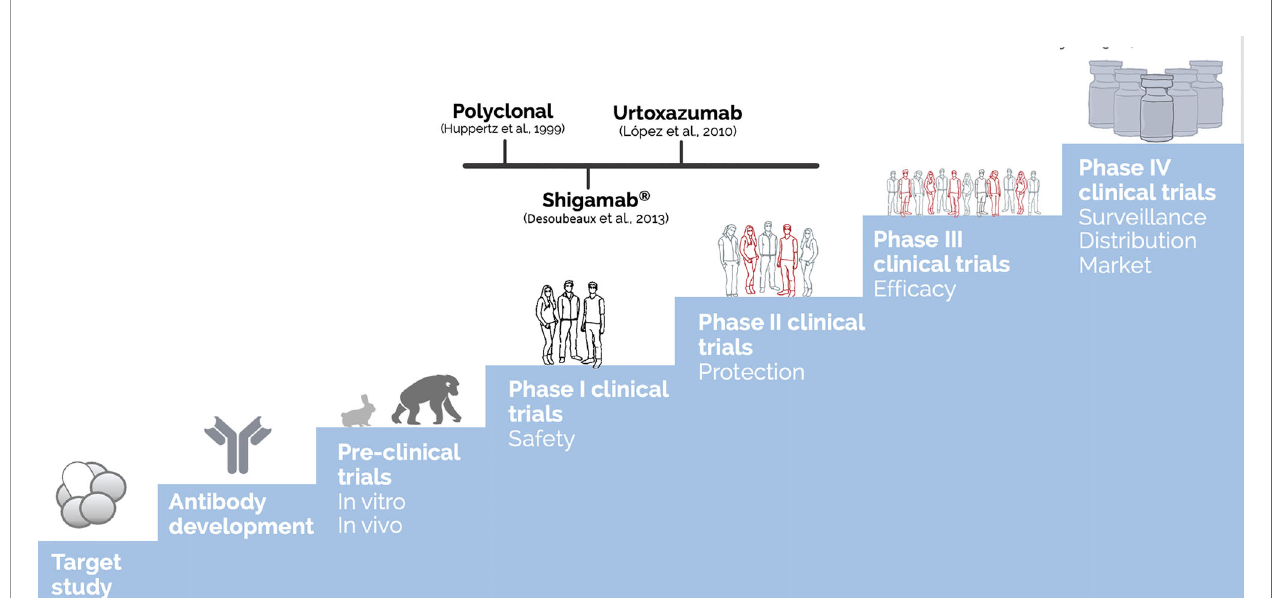
FIGURE 3 | Development steps of biopharmaceuticals until human use approval and the most advanced antibodies raised against Stx. The discovery of a new drug as therapeutic antibodies starts with the target study followed by the antibody development (choosing of which antibody, type, format, avidity, and af fi nity) and achieving the functional test in vitro and in vivo (using different animal models, starting with mice and rabbits until the most closely related to humans as apes), reaching the challenge assay in an animal model, which is part of the preclinical trials. Once the molecule shows relevant ability to neutralize the effect of the target, human clinical trials could be performed. The clinical trials are generally divided into four phases: The fi rst one enrolls dozens of volunteers, and the main endpoint is to test the safety of the molecule. By phase II, the molecule is tested in hundreds of volunteers to attest protection towards the toxin effect. At the last phase before regulatory agency approval, controlled randomized double-blind assays are performed in millions of volunteers to test the molecule ef fi cacy. Once passed at those clinical trials, the therapeutic molecule can be approved by the regulatory agencies to be administered in humans, which is considered phase IV, in which the surveillance of its long-term administration is going to take place (Tamimi and Ellis, 2009). The polyclonal developed by Huppertz (Huppertz et al., 1999) and Shigamab ® (Desoubeaux et al., 2013) tested safety as a phase I clinical trial. On the other hand, urtoxazumab tested safety and pharmacokinetic, which could be considered a clinical trial 1/2 (Lo ́ pez et al.,